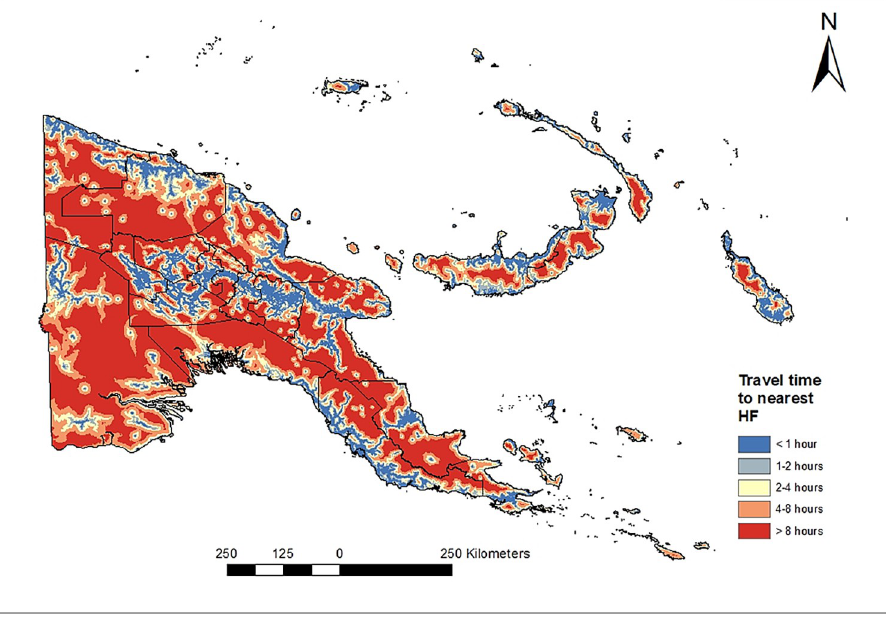
Fig 3. Travel time (hours) of the population from their residential places to nearest health facilities. Travel time from raster pixels (30x30 m 2 ) to nearest HF was calculated using the fastest mode of transportation. Source of the map base layer: WFP-World Food Programme, 2019. Source of the map base layer: WFP-World Food Programme, 2019. Map created by the authors using a licensed ArcGIS Desktop 10.5 software from Esri (http://www.arcgis.com/).